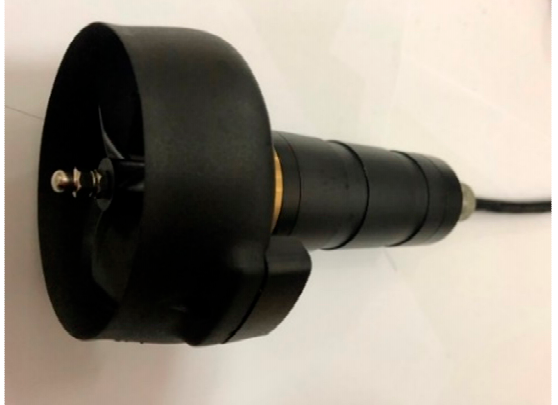
Figure 4. Underwater